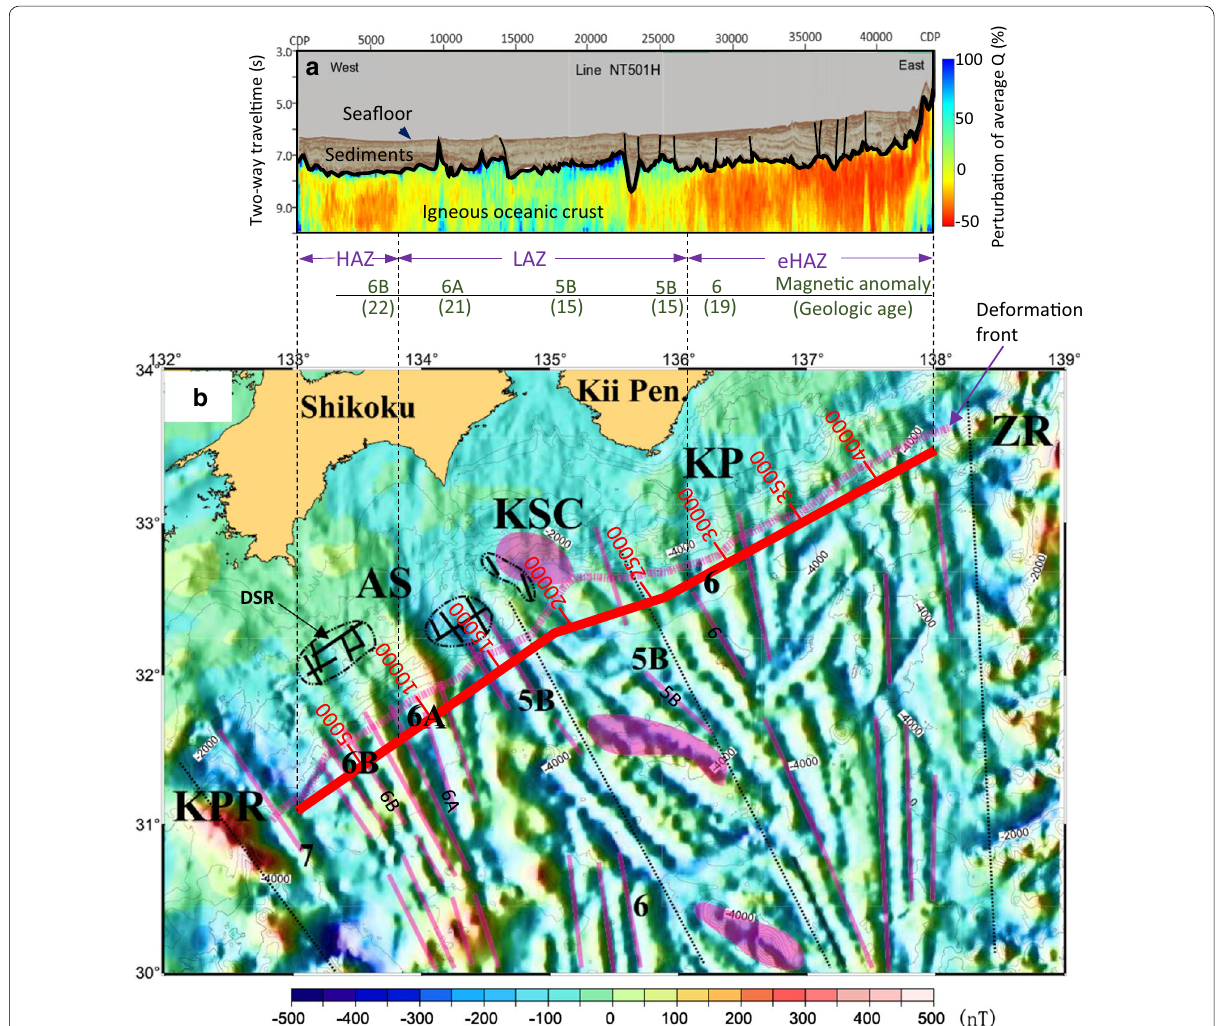
Fig. 12 Comparison between magnetic anomaly and seismic attenuation structure. The boundary of attenuation properties HAZ and LAZ is well correlated to that of the magnetic anomalies 6B and 6A by Kido and Fujiwara (2004). KPR, AS, KSC and KP represent Kyushu paleo ridge, Ashizuri, Kinan seamount chain and Kii peninsula, respectively. These five regions are divided by thin dotted lines. Pink solid lines indicate magnetic linea‑ tions. Pink shaded areas show the Kinan Seamounts. DSR represents deep strong reflector discovered by Park et al.